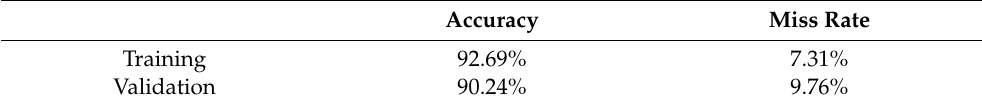
Table 4. Performance Evaluation of the suggested Vehicle-based COVID-19 Detection System (VCDS) in Validation &